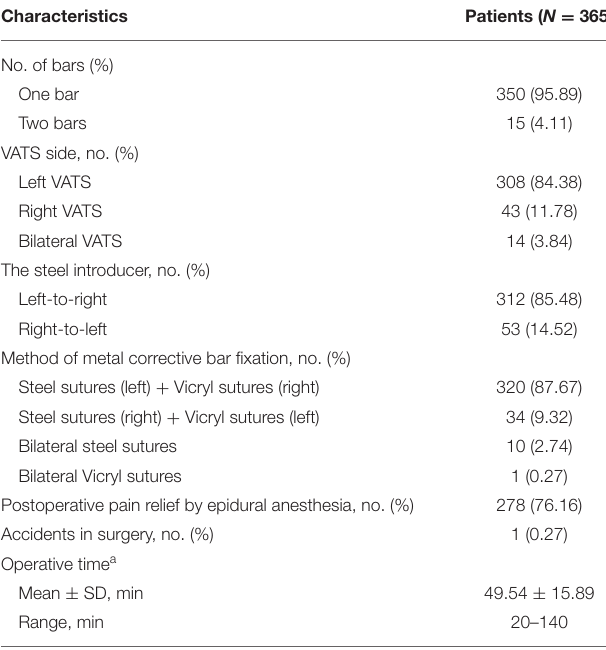
TABLE 3 | Operative characteristics of patients. TABLE 4 | Postoperative characteristics of